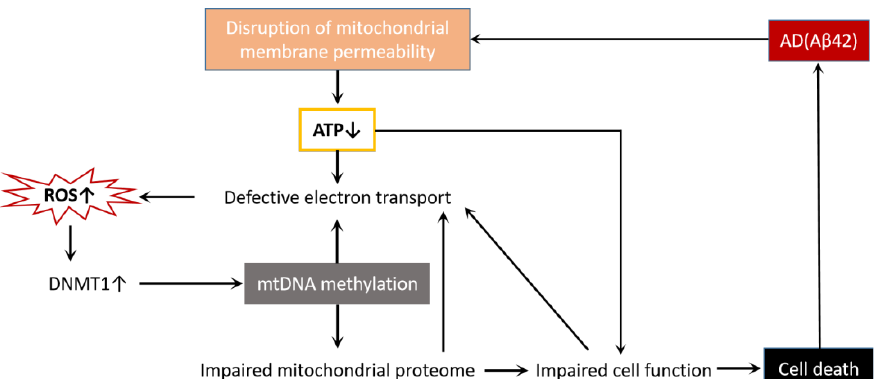
Figure 4. AD and cell death interact through mitochondrial dysfunction. Aβ42 disrupts mitochon- drial membrane permeability, reduces ATP production, disrupts electron transport chains, and causes ROS accumulation. The increase in ROS activates DNMT1, leads to mtDNA methylation, impairs mitochondrial proteases, affects the normal function of cells, and finally causes cell death. Additionally, mtDNA methylation, mitochondrial protease impairment, and cell dysfunction all make the electron transport chain defective, forming a vicious cycle and exacerbating cell death. Table 1. mtDNA methylation detection in different AD